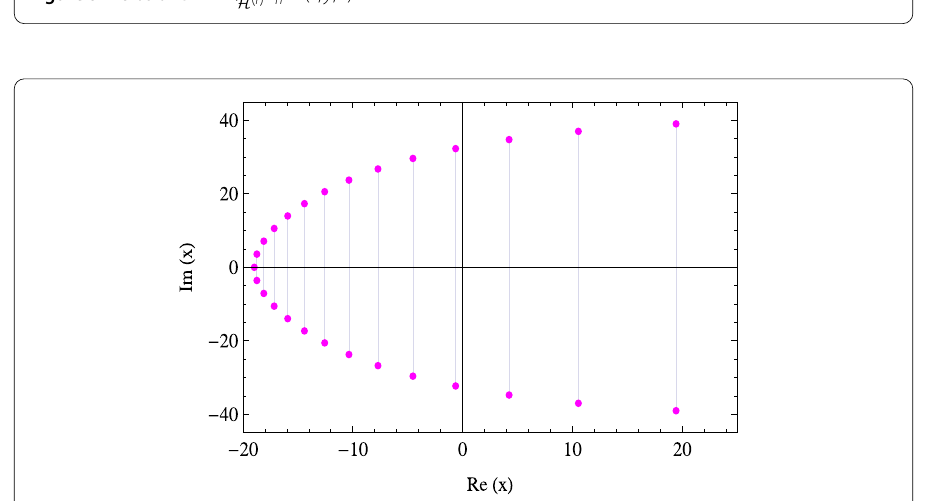
Figure 4 F ( c , v ) 30 ( x , b , c ) has Im( x ) = 0 reflection H ( r )